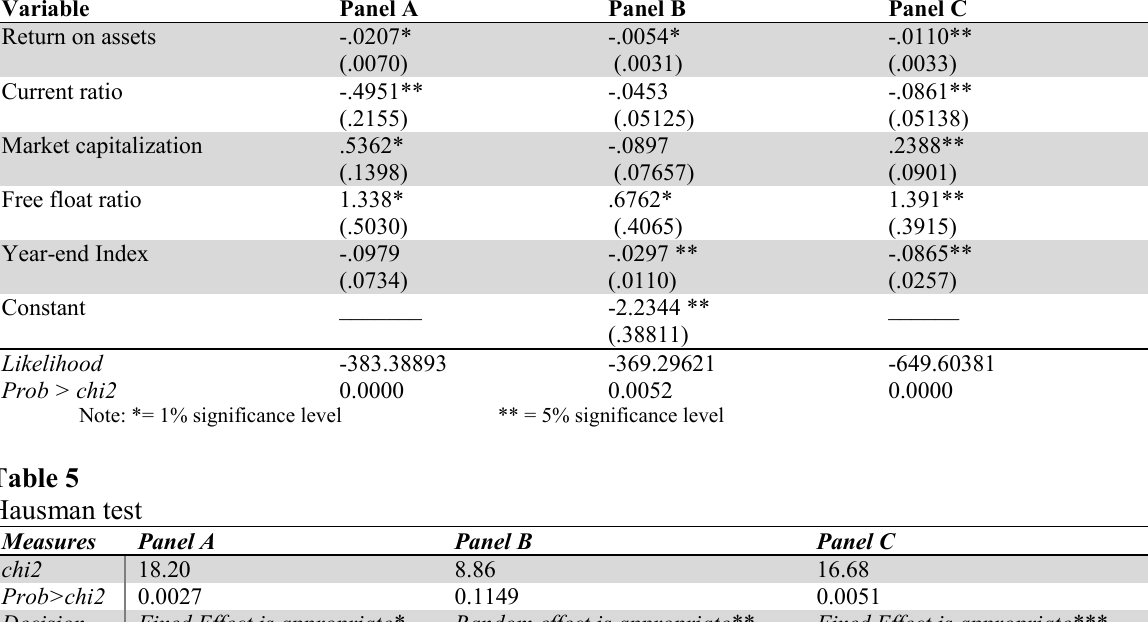
Panel Logit Regression